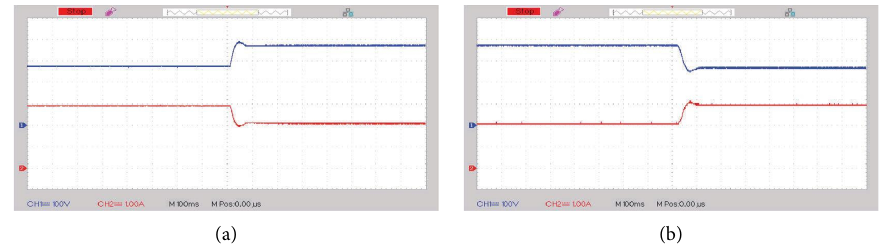
Figure 33: Dynamic response of the suggested converter. (a) Increasing output voltage. (b) Decreasing output